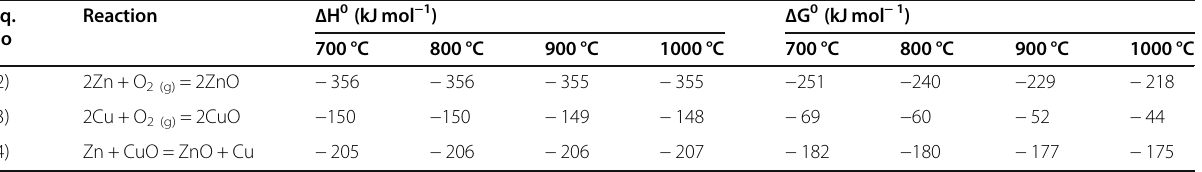
Table 2 Thermodynamic values for reactions involved in the oxidation of brass slag [22] Eq. no